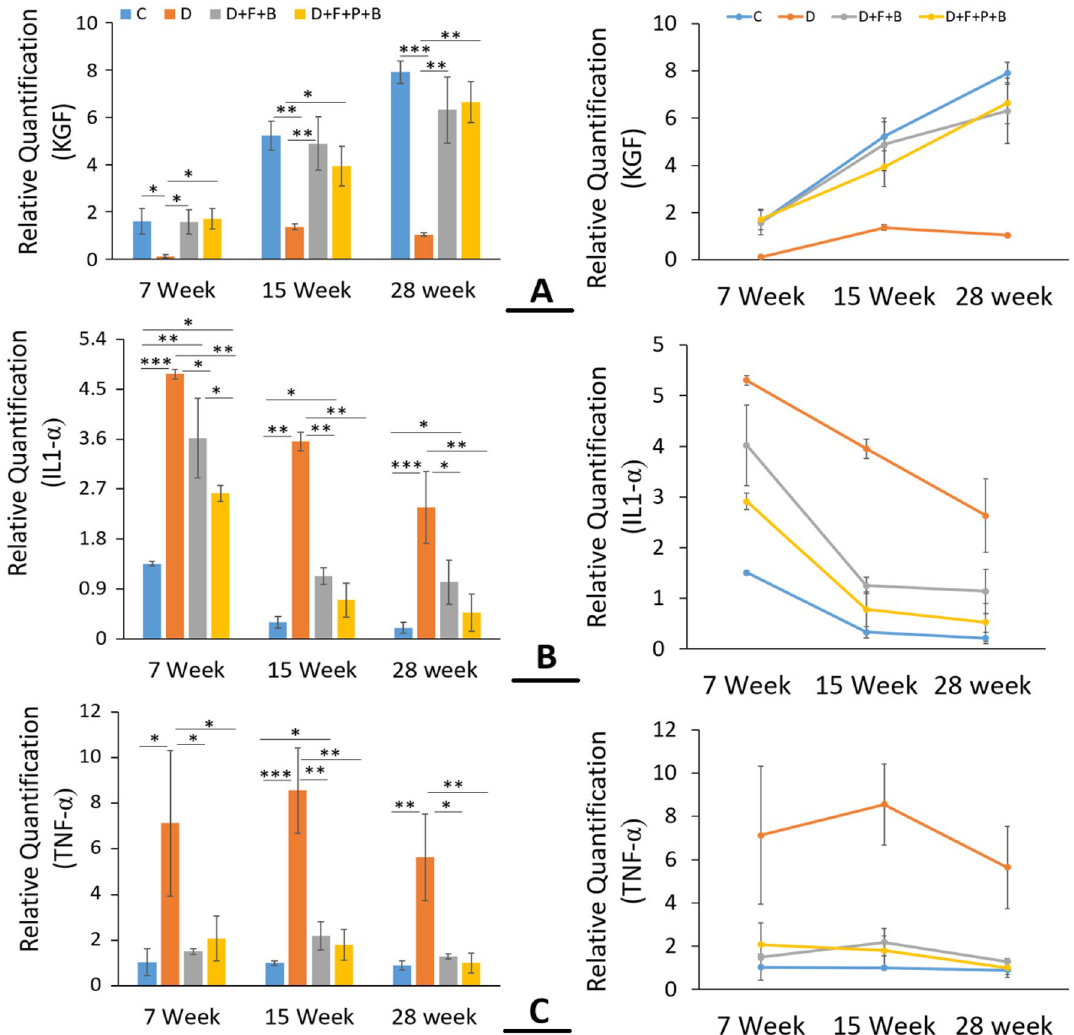
Figure 11. Molecular analysis of wound tissue at different time points post-injury. ( A – C ) Mean ± SD of the levels of mRNA expression in KGF, IL1-α and TNF-α at days 7, 5 and 28 post-injury in the wound healing site in the study groups as compared by the ANOVA and LSD; (*P < 0.05, **P < 0.01 and ***P < 0.001) and Repeated measures ANOVA. ANOVA, analysis of variance and LSD, least significant difference; C; D; D + F + B; D + F + B +